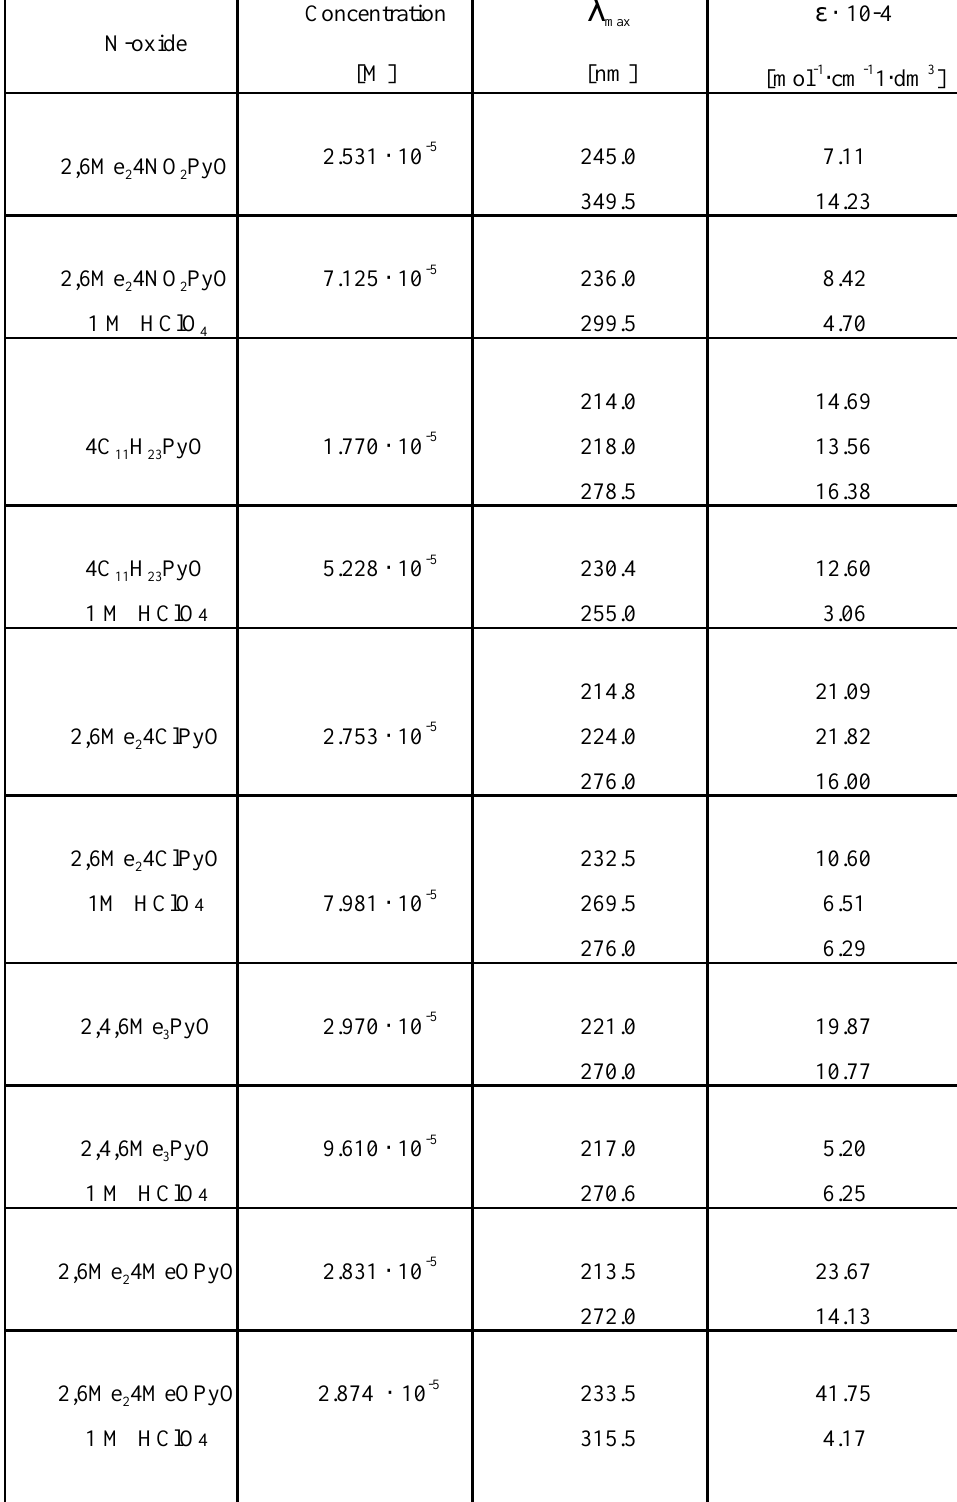
Table 2. UV spectral characteristics of free and protonated substituted pyridine